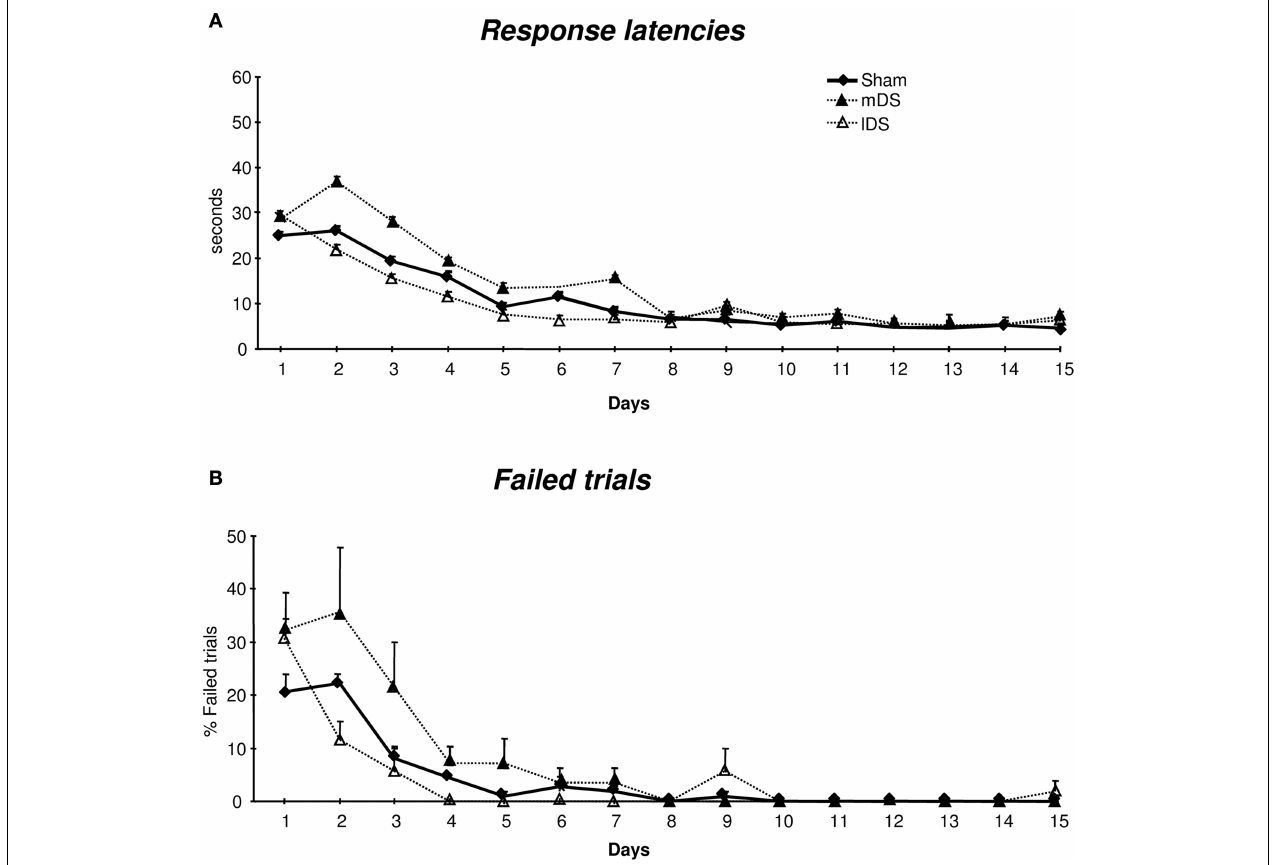
FIGURE 5 | Performance across the 15 training days of acquisition in the water-maze. (A) Group means of response latencies (sec ± SEM). (B) Group means of failed trials ( ± SEM) in Sham, mDS- and lDS-lesioned